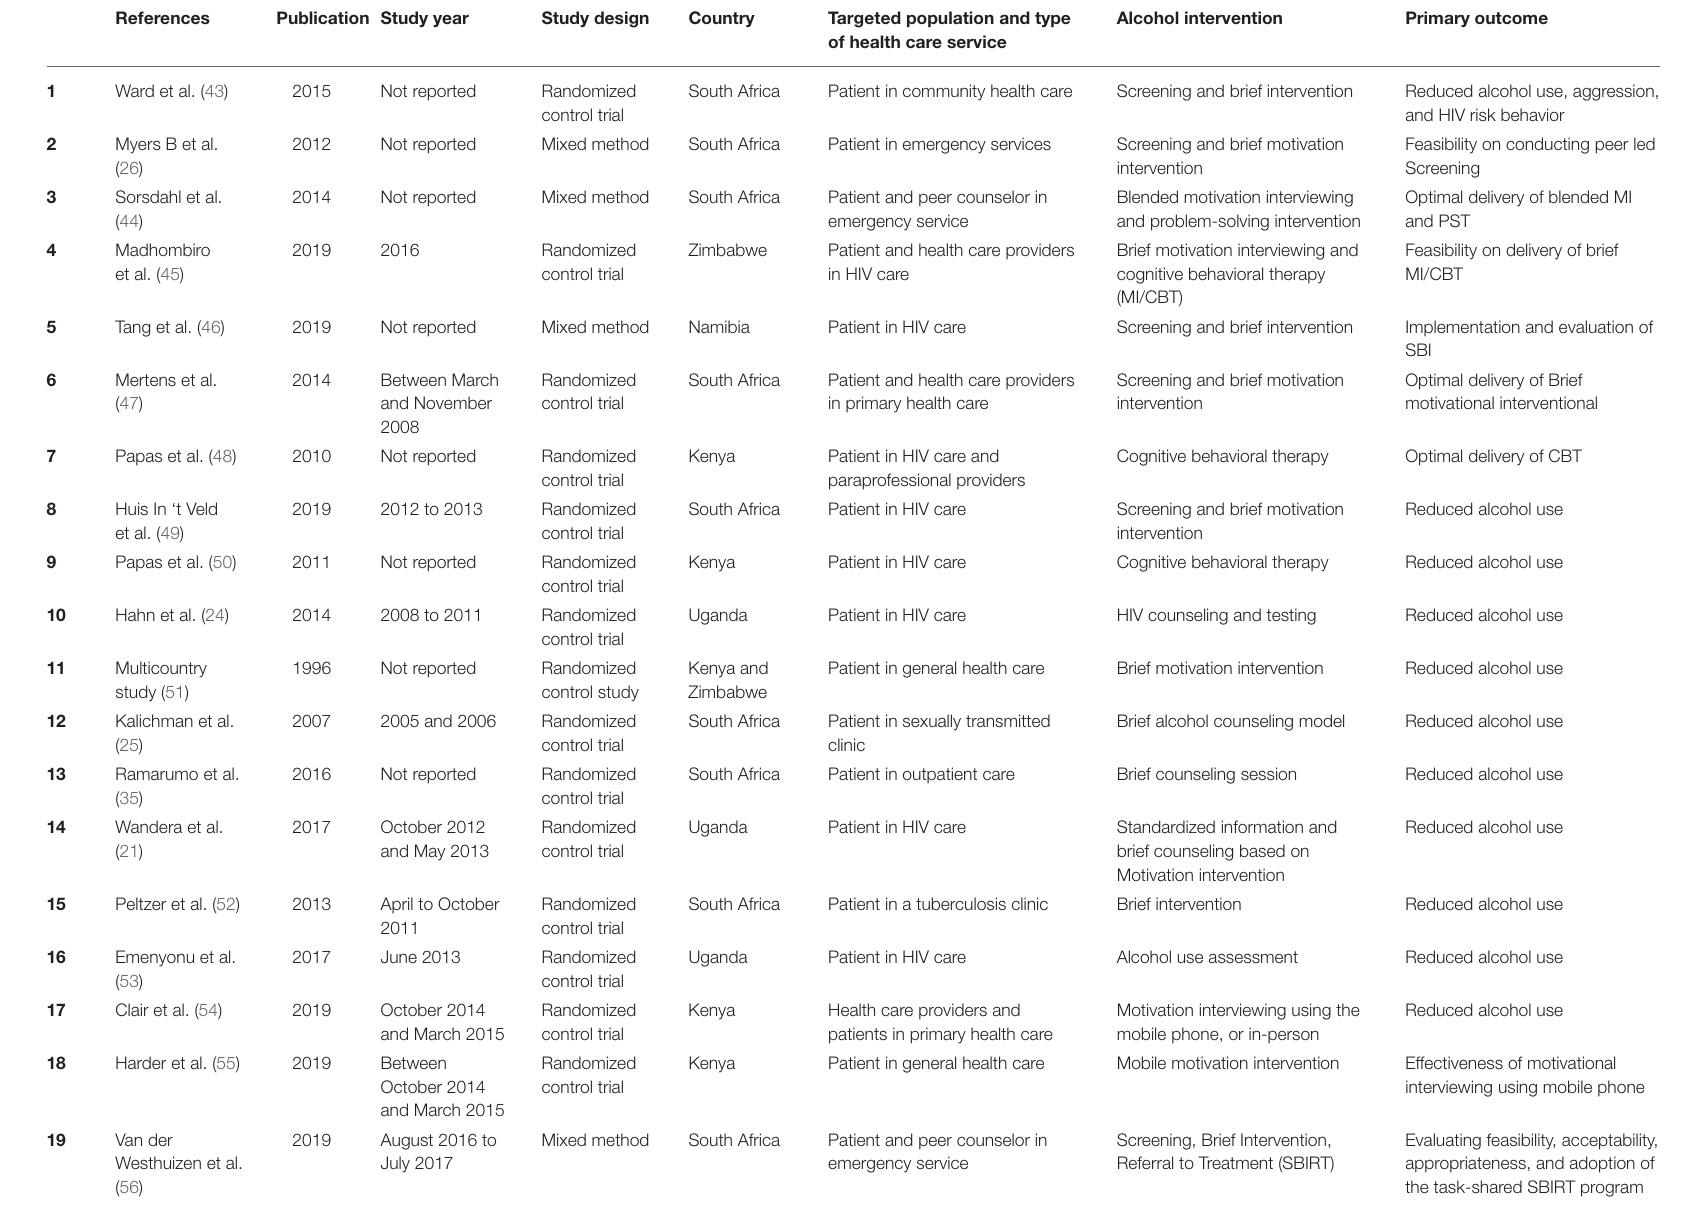
TABLE 1 | Description of interventions for alcohol use disorder in Sub Saharan Africa general health care